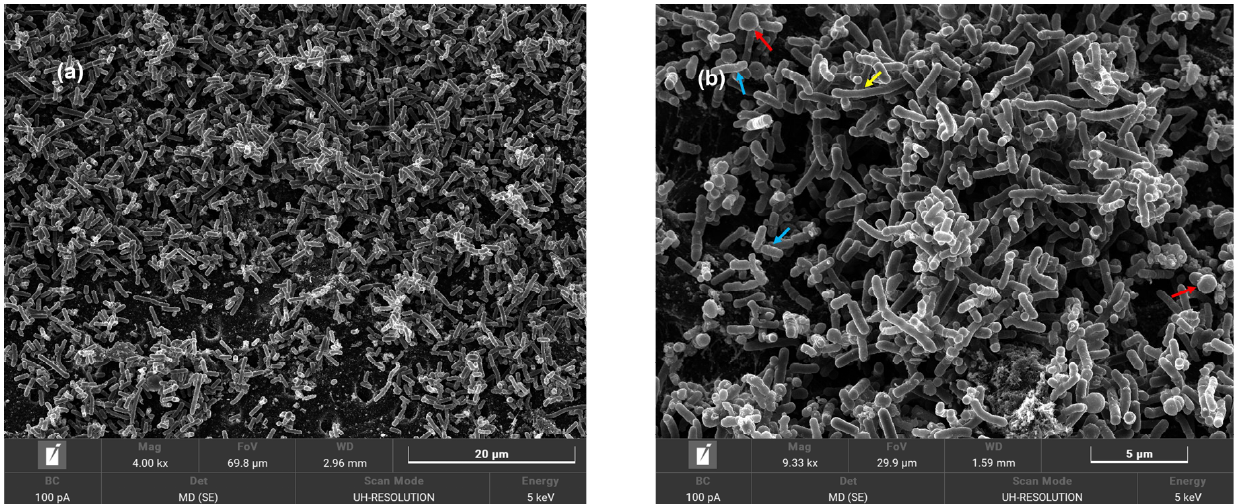
Figure 1. Representative scanning electron microscopy images showing the growth of polymicrobial biofilms in infected dentin samples: ( a ) × 4000; ( b ) × 13,000. Note the diversity of microbial composi- tion (different colored arrows represent different species and bacterial shape types) grown within close proximity. Antagonistic and cooperative synergistic microbial interactions play an essential role in ecological regulation and endodontic biofilm formation.